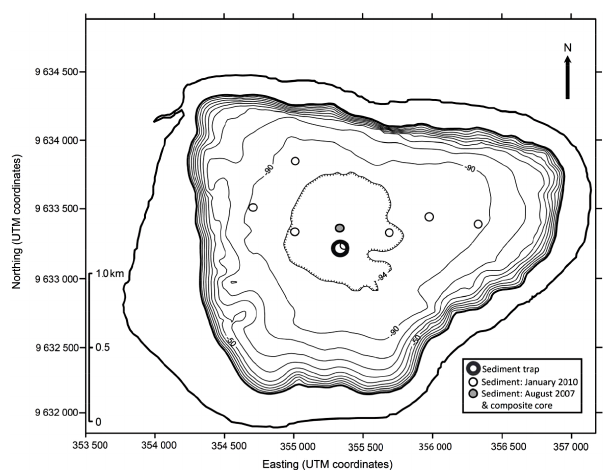
Figure 1. Map of Lake Challa and its volcanic crater catchment with bathymetry (Moernaut et al., 2010) and sampling sites relevant to this study: the sediment trap suspended at 35m water depth, the composite sediment sequence covering the last 2200 years, and in- tact profundal surface sediments collected in August 2007 (CH07) and January 2010 (CH10). The outermost bold black line denotes the catchment area boundary, which coincides with the crest of the crater rim except in the northwestern corner, where it is breached by a 200m ravine (see